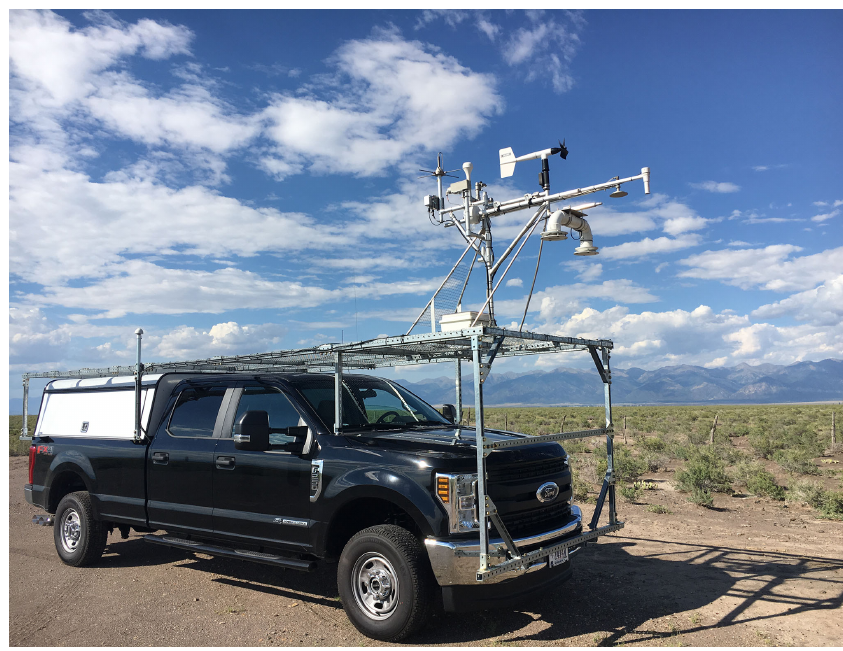
Figure 2. The NSSL mobile mesonet during the LAPSE-RATE. Photo credit Dr. Sean Waugh, NOAA/NSSL.